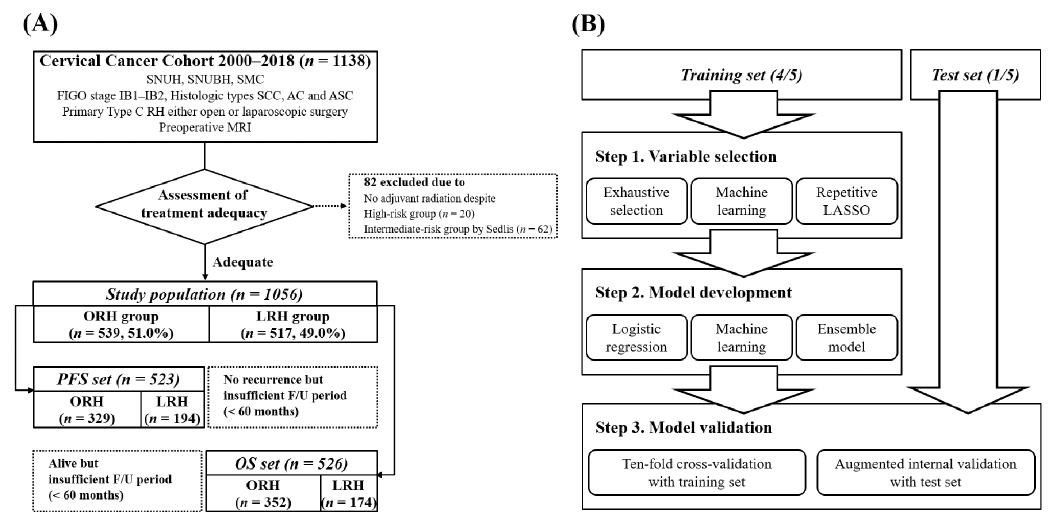
Figure 1. Flow diagrams of this study: ( A ) selection of the study population; ( B ) consecutive processes of model construction.